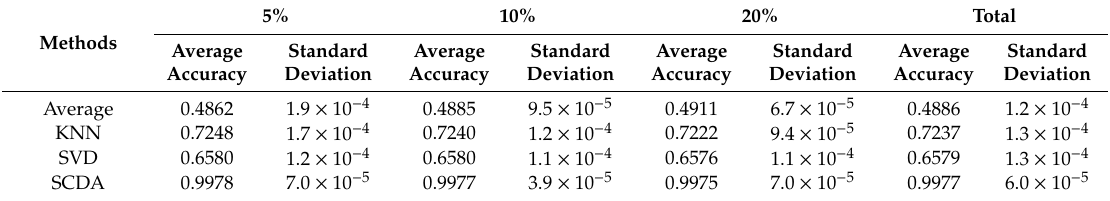
Table 3. Performance comparison on yeast genotypes at three missing scenarios.